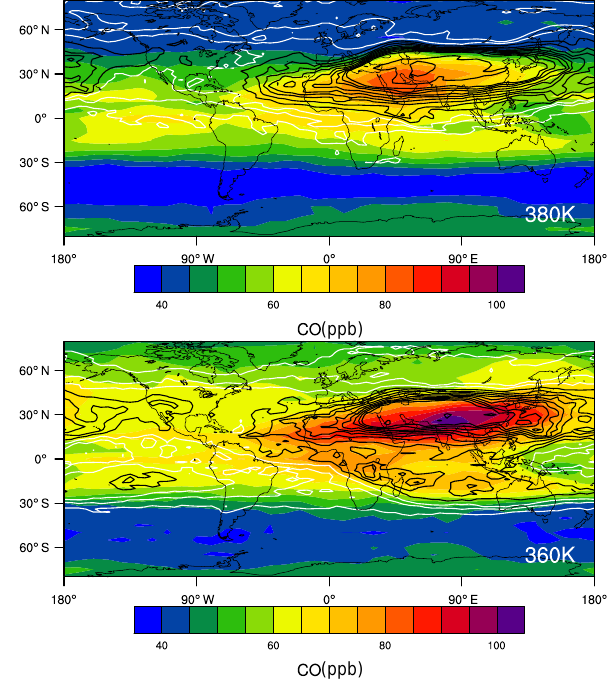
Figure 4. Mean JJA distribution of parcel locations averaged over day 20–30 (white: 0.02 to 0.07%; black: 0.08 to 0.25%) overlaid on mean JJA CO concentrations as measure by Microwave Limb Sounder (MLS) at 380K (top panel) and 360K (bottom